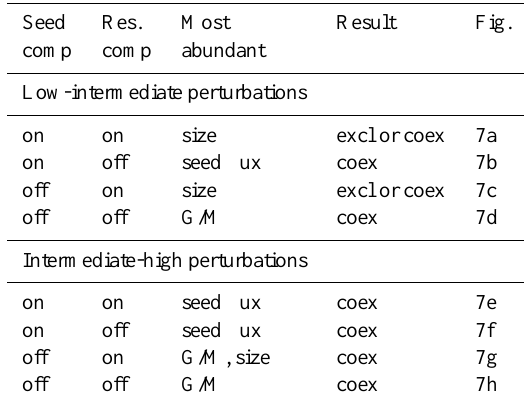
Table 3. Summary of impacts of competition and perturbations for steady state of population dynamics. The most important character- istic to be most abundant in steady state is given and if competitive exclusion (excl) or coexistence (coex) occur. If neither seed or re- source competition operate, the ratio κ grow /κ mort (G/M) is impor- tant for being abundant. Result